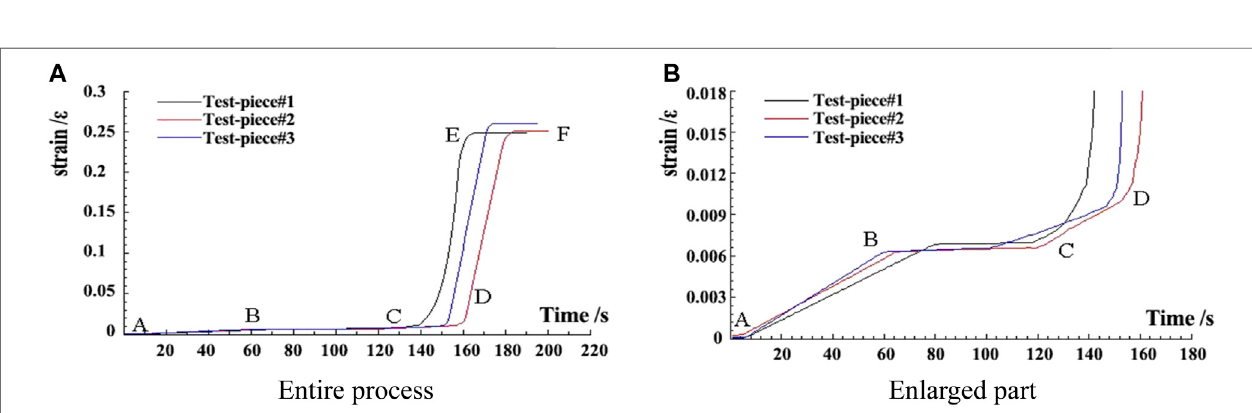
FIGURE 7 | Time history curves of strain of anchor cable specimens. (A) Entire process. (B) Enlarged part.